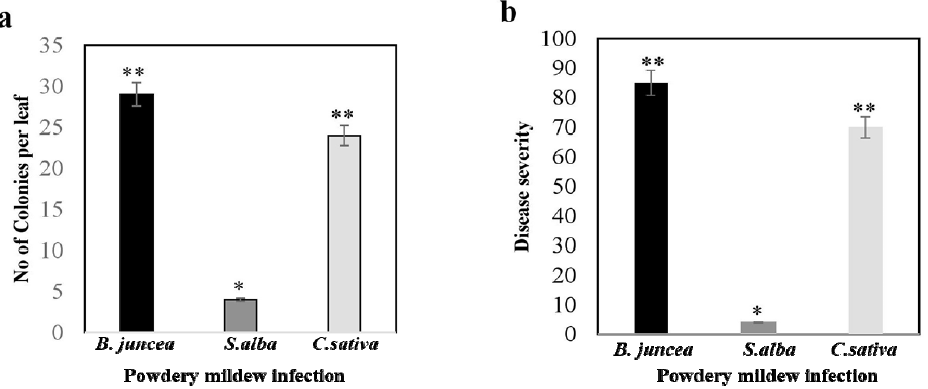
Figure 2. Powdery mildew disease scoring in B. juncea , S. alba and C. Sativa plants: ( a ) number of powdery mildew colonies and ( b ) disease severity. Asterisks shows statistically significant (* p < 0.05) or extremely significant (** p <